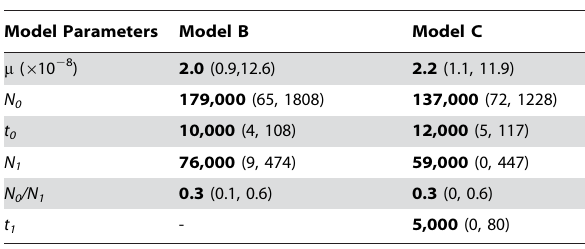
Table 1. Estimates and 95% credibility intervals of parameter values under the variants of models B and C with variable mutation rates.